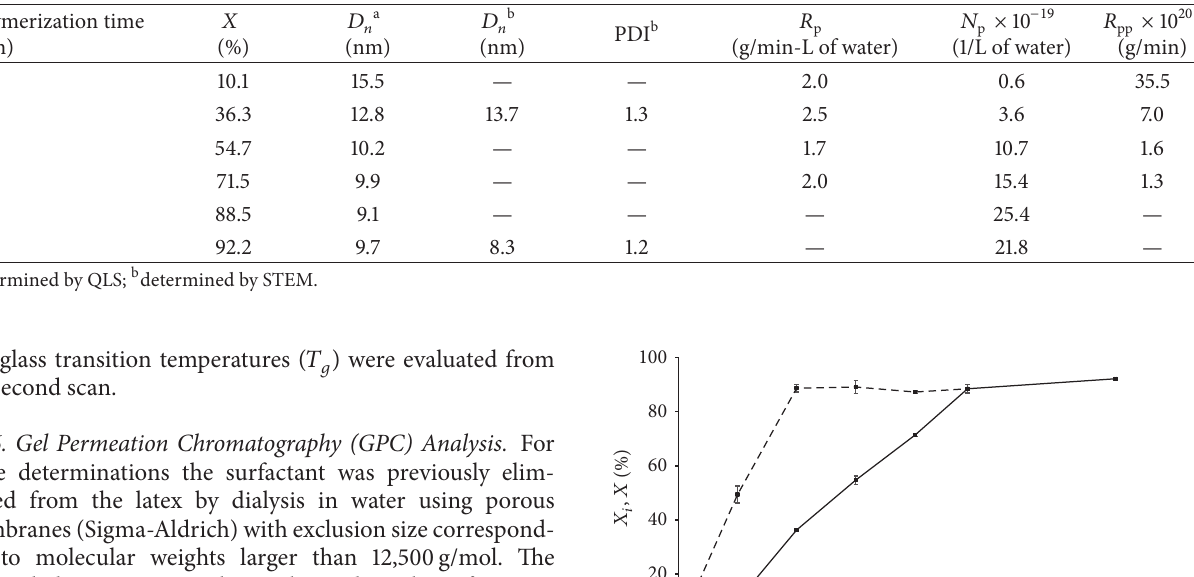
Table 1: Results characterizing particle size, particle number, and polymerization rates along the copolymerization of MMA/MAA (2/1, mol/mol).